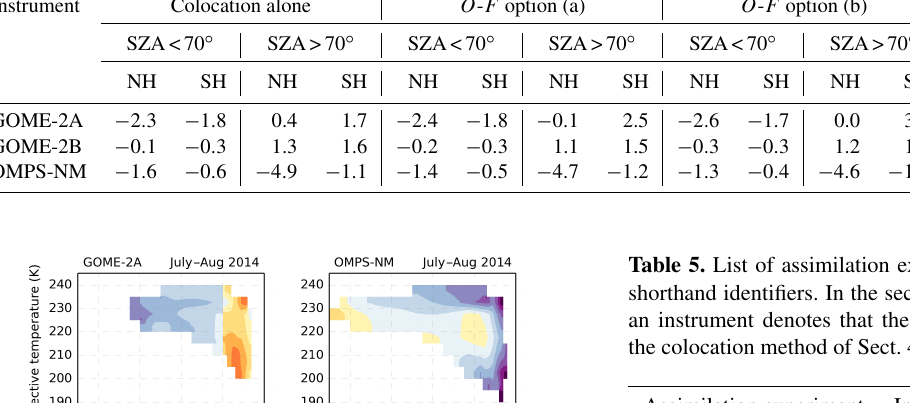
Table 4. Mean differences in total column ozone (%) between satellite instruments and OMI-TOMS for July–August 2014 using the options (a), (b), and (c) from Sect. 4.2, for the Northern Hemisphere and Southern Hemisphere and solar zenith angles below and above 70 ◦ . Instrument